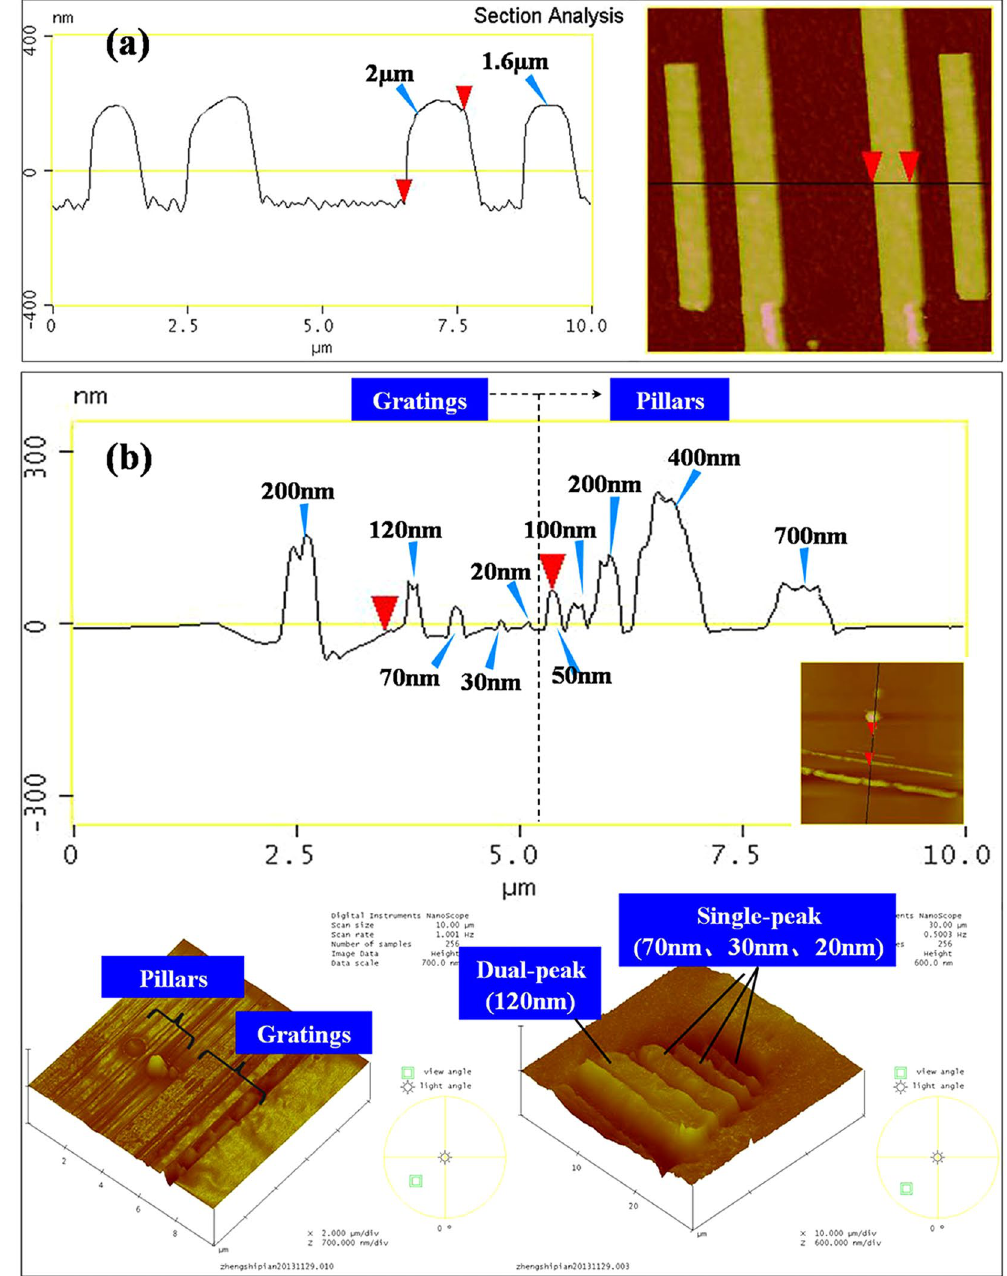
Figure 2. The filling peak of 996 kD PMMA at different scales. ( a ) The single-peak filling mode of PMMA at micron scale. ( b ) The filling peaks at a scale from sub-microns to molecular